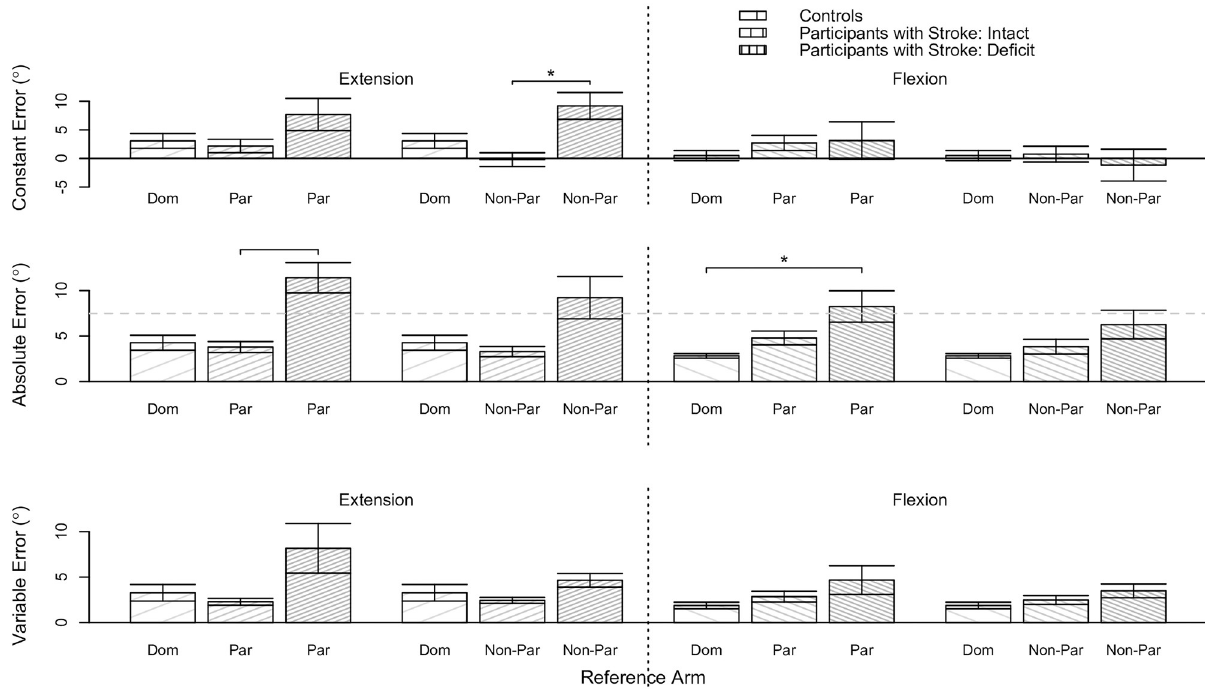
Fig 7. Between-arms position-mirroring results as a function of group classification. Shown are the robotic assessment results for the between-arms position-mirroring experiment based on our classification of participants. Mean (bar height) and standard error (error bars) of the (Top) constant error, (Middle) absolute error, and (Bottom) variable error are given as a function of the reference arm and reference target location for each classified group of participants. The gray dashed horizontal line indicates the deficit threshold of 10.1˚. Black solid horizontal lines with a star above indicate significant effects. The controls’ data are reproduced from [48] to permit comparison of the between-arms position-mirroring ability of our participants with stroke to that of individuals without neurological impairments. (Dom: dominant, Non-Dom: non-dominant, Non-Par: non-paretic, Par: paretic).